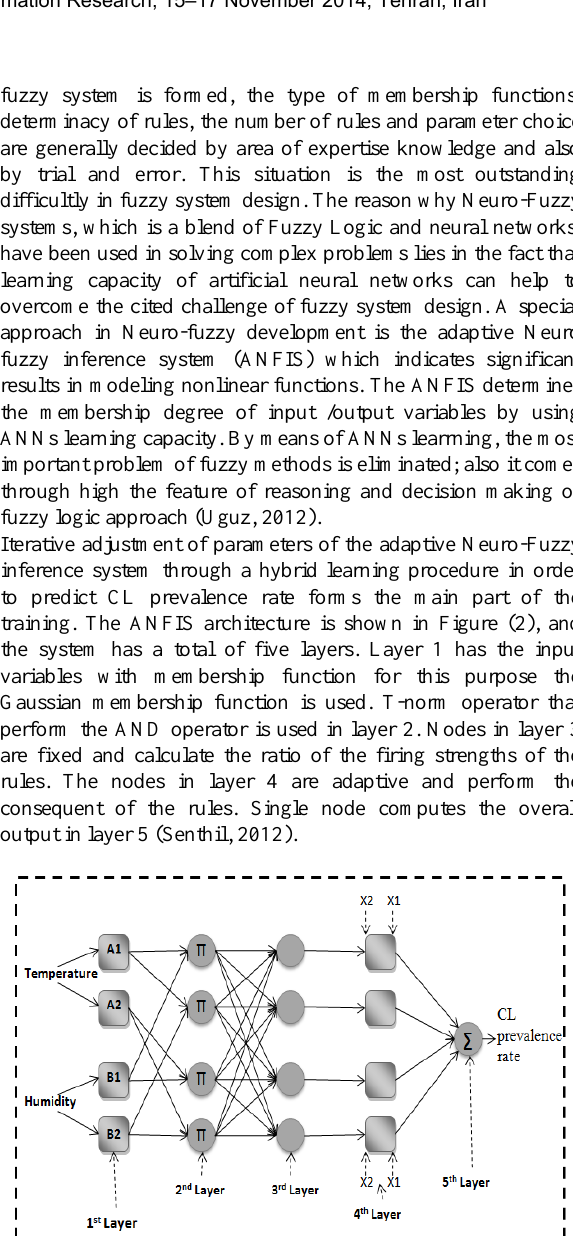
Figure2.The architecture of